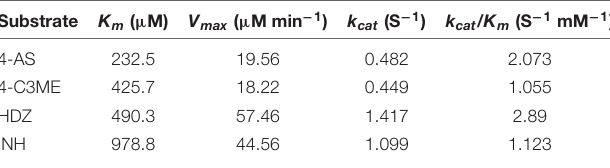
TABLE 1 | Kinetic parameters for V. vulnificus N-acetyltransferase determined from Michaelis–Menten kinetics